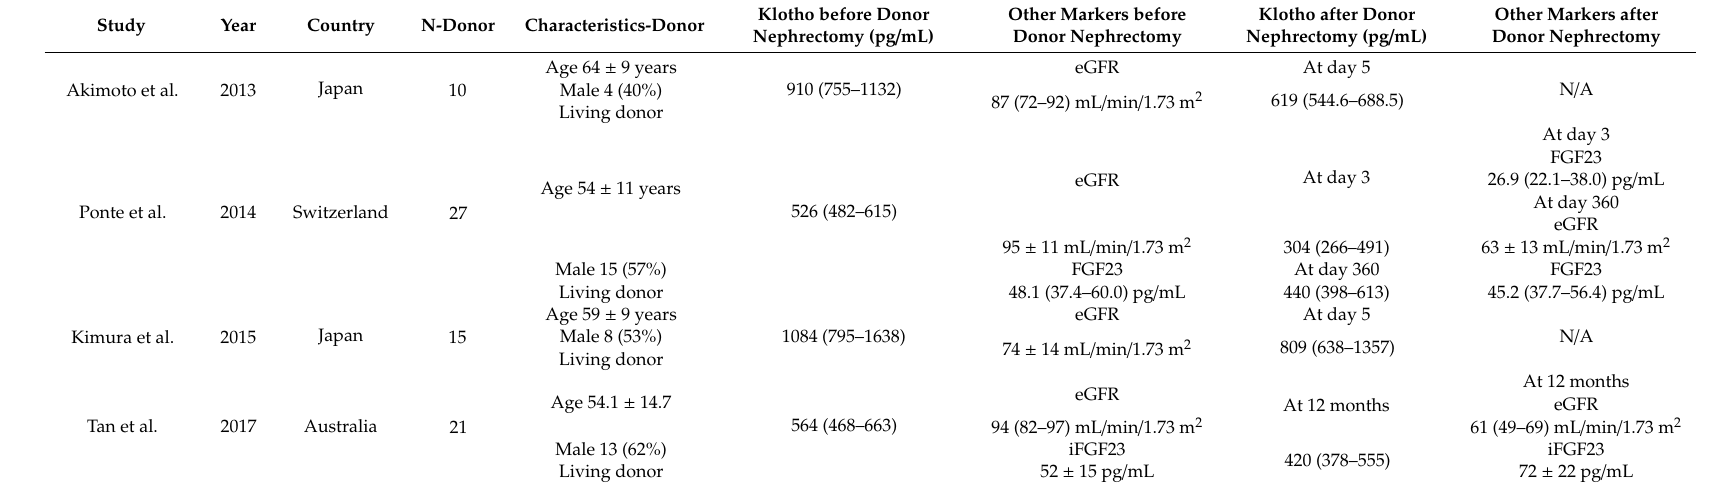
Table 3. Characteristics of the included studies evaluating serum klotho after living kidney donation.